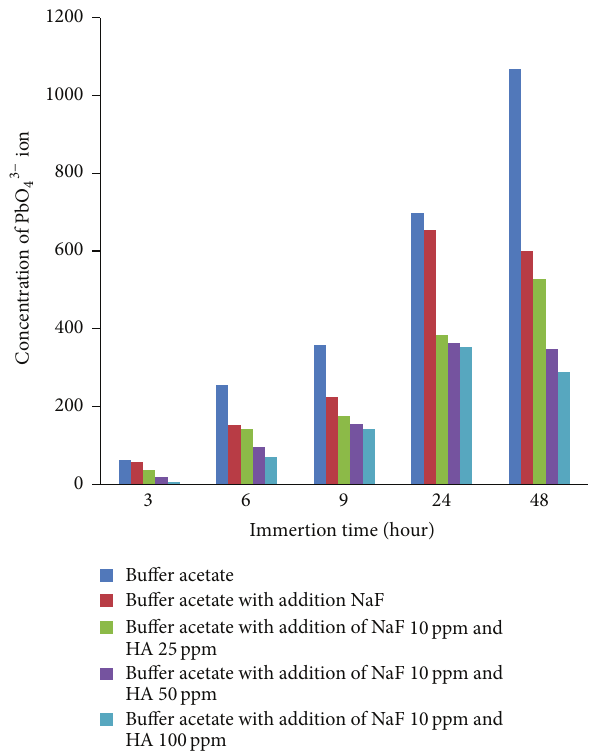
Figure 11: Relationship between teeth immersion time versus PO 43 −